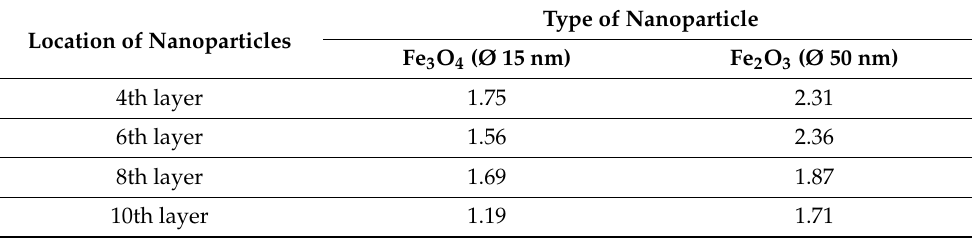
Table 1. Iron content in microcapsules ( µ g/10 10